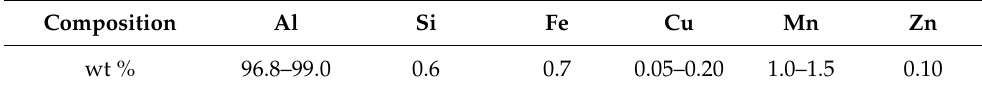
Table 1. Chemical composition of aluminum alloy (AA3003)